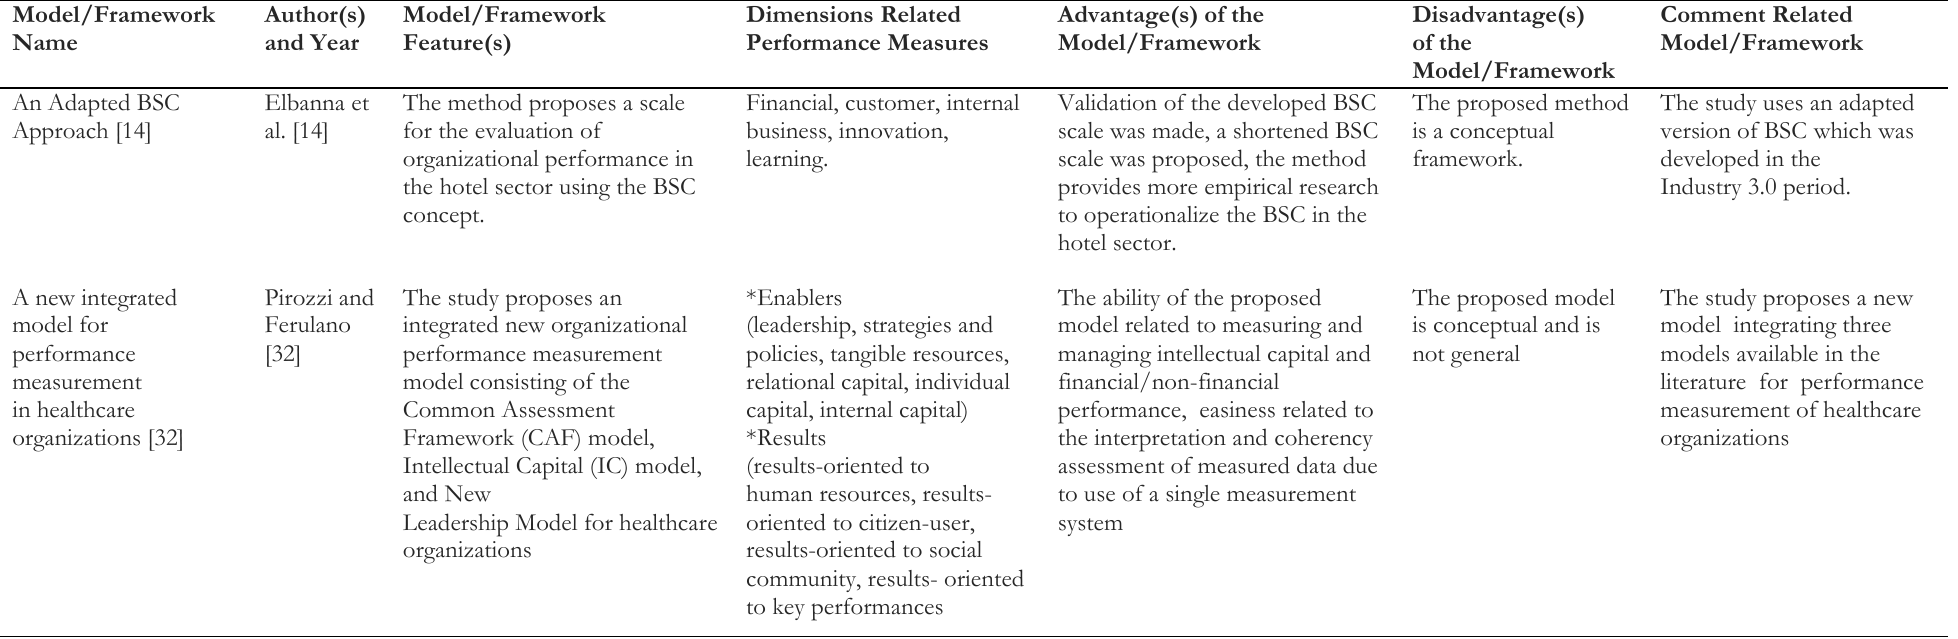
Table 2. Organizational performance measurement models developed in Industry 4.0 period.